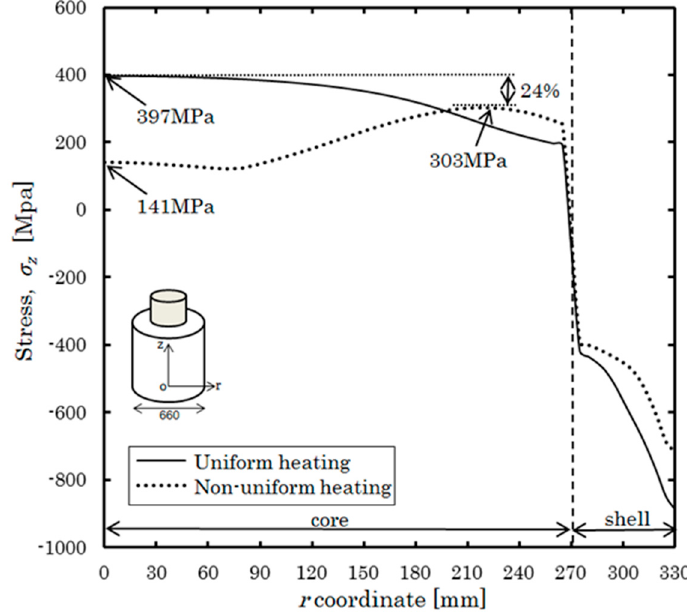
Figure 6. Comparison of residual stress distribution, 𝜎 (cid:3053) , for both heating treatments.